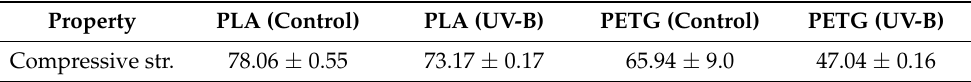
Table 3. Compressive